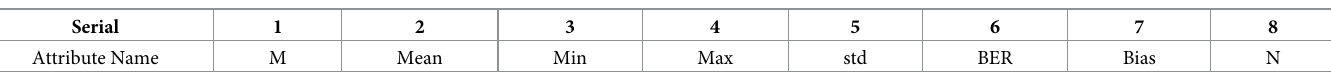
Table 1. Dataset attributes.